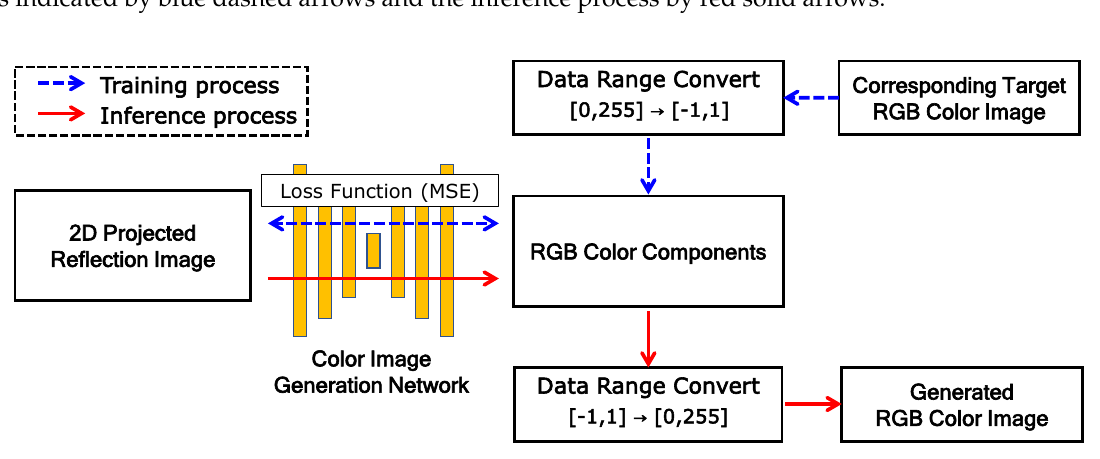
Figure 5. Training and inference processes in the proposed